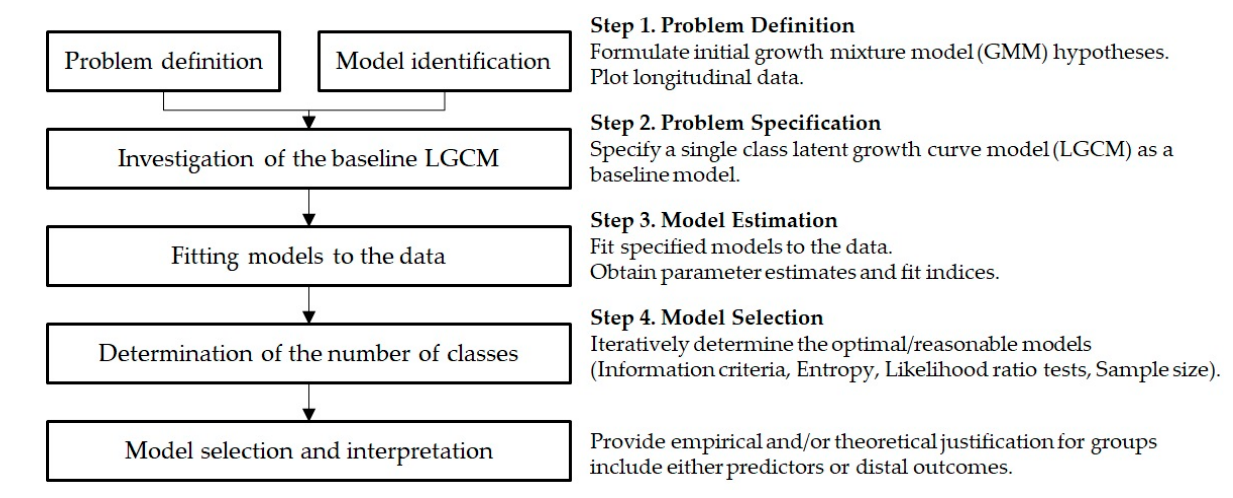
Figure 2. Analytic procedure for GMM research.